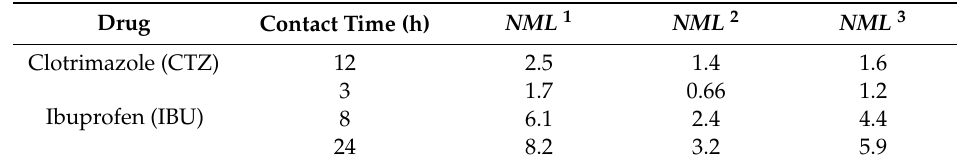
Table 5. NML of the drug on the carrier surface calculated with Equation (2) with di ff erent values of a drug . Drug Contact Time